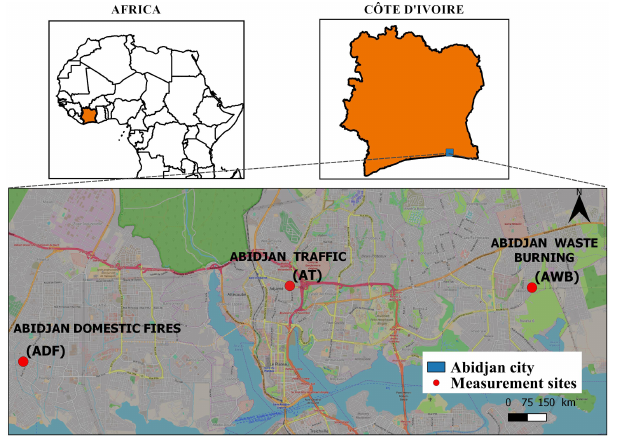
Figure 3. Pictures of the different sampling sites: (a) traffic in Cotonou (Benin, CT station); (b) waste burning in Abidjan (Côte d’Ivoire, AWB station); (c) domestic fire, showing smoking activity in Yopougon, Abidjan (Côte d’Ivoire, ADF station); and (d) “woro- woro and Gbaka” traffic in Abidjan (Côte d’Ivoire, AT